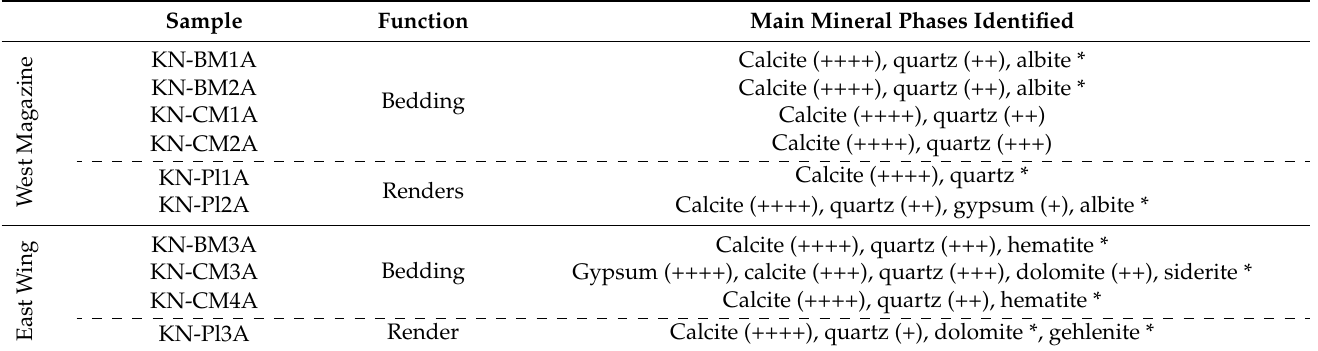
Table 4. Main crystalline phases identified by XRD in the samples of the Palace of Knossos.